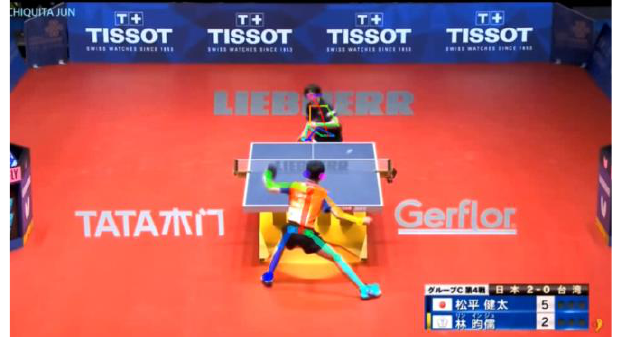
Figure 4. CPU version to compute the pose of a person in a video in real time (0.2 fps).